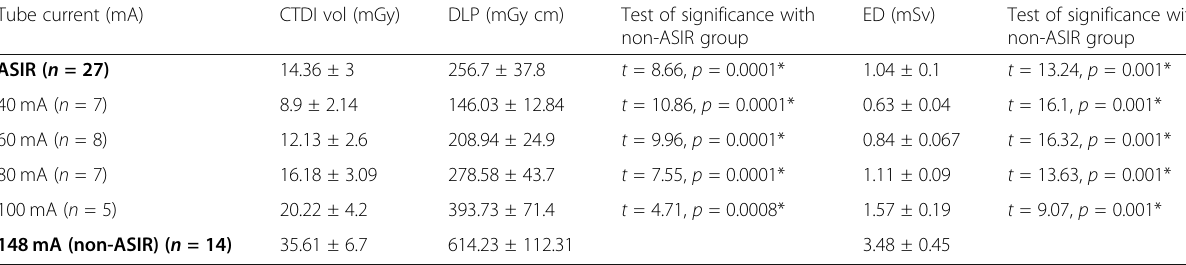
Table 3 Comparative data of radiation CT dose analysis data of the ASIR and non-ASIR groups Tube current (mA) CTDI vol